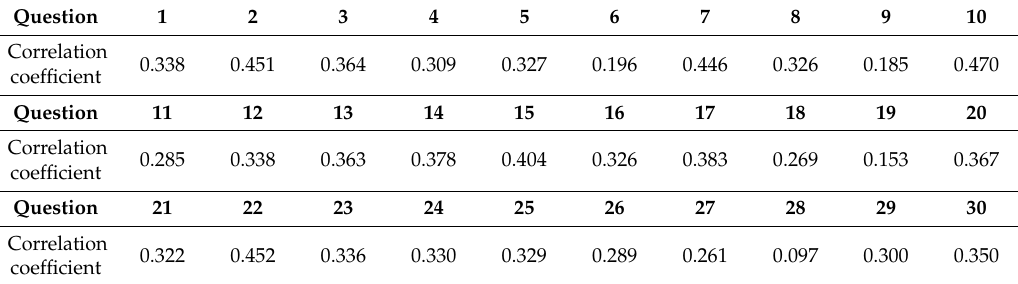
Table 2. Total correlation coefficients of 30